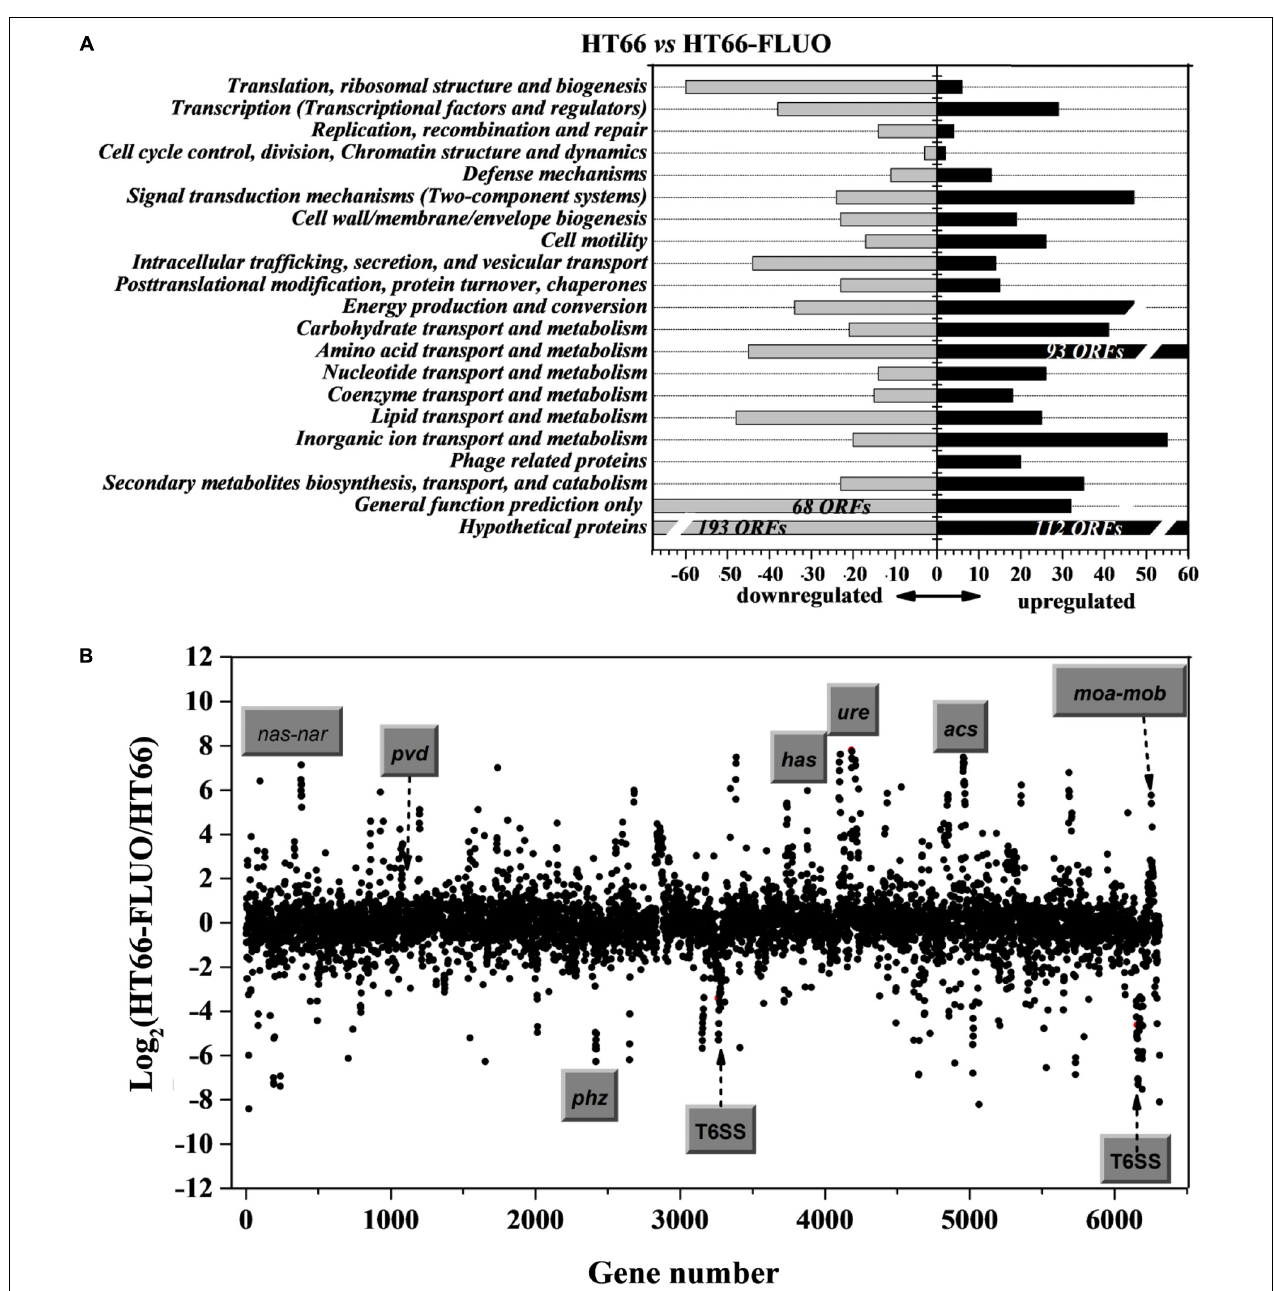
FIGURE 3 | (A) Functional classification of differential levels of gene expression with a fold change of at least 2.0 was performed according to P. chlororaphis HT66 in NCBI database. Gray and black bars represent the number of significantly downregulated and upregulated genes, respectively. (B) Scatter plot comparing the transcriptomes of P. chlororaphis HT66 and HT66-FLUO. The x -axis shows gene number in the HT66 genome; the y -axis shows the log 2 of fold change of transcript abundance of each gene in the HT66-FLUO relative to HT66. The highly modulated and function-known gene clusters are